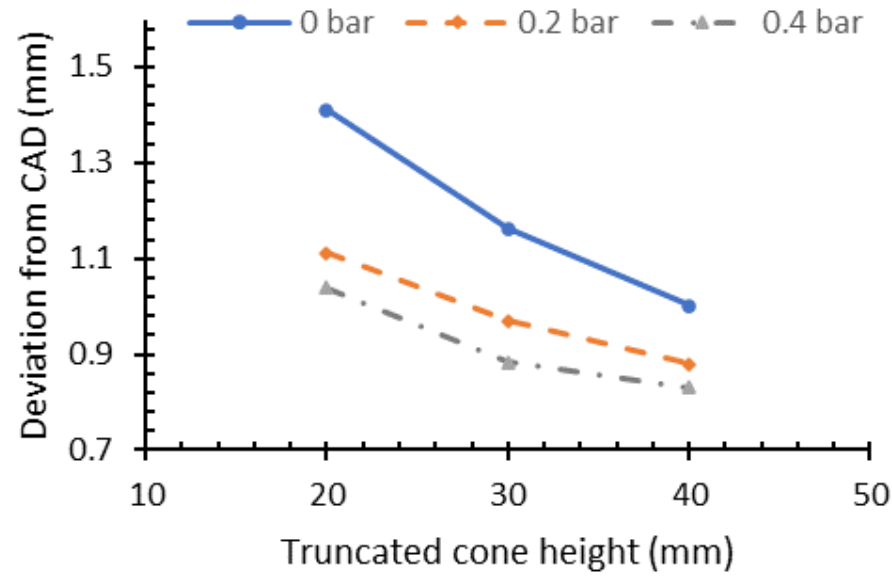
Figure 10. Deviation from CAD of deformed blanks.